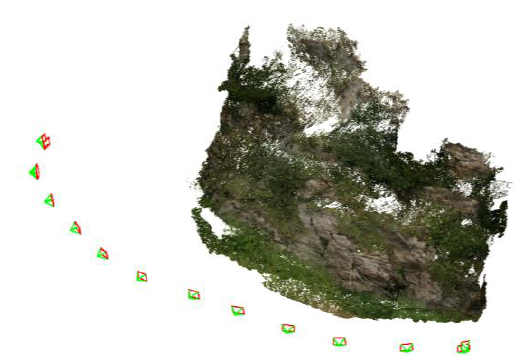
Figure 2. Example for a dense point cloud and the